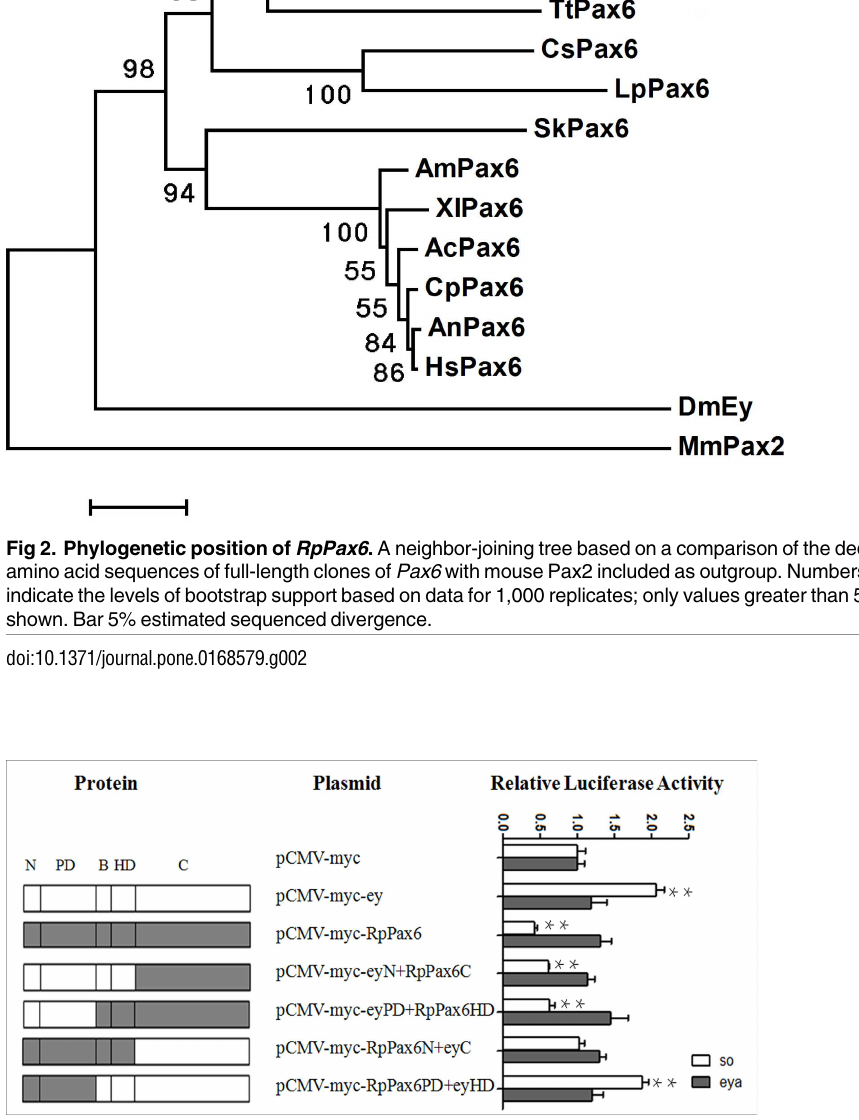
Fig 3. Structural-functional analysis of ey and RpPax6 . Schematic summaries of the originaland chimeric constructs are listed in the left column. The right column shows the effect of ey and RpPax6 proteins with or without mutation on promoter activity of pGL3-so and pGL3-eya. The assay was carried out in 293T cells as describedin Materialsand Methods. Luciferaseactivities are shown relative to those of pCMV-myc. pSV- β - galactosidase was includedin transfectionas an internal control of the transfectionefficiency. The values are the means from three independentexperiments ± SE. ** P < 0.01.